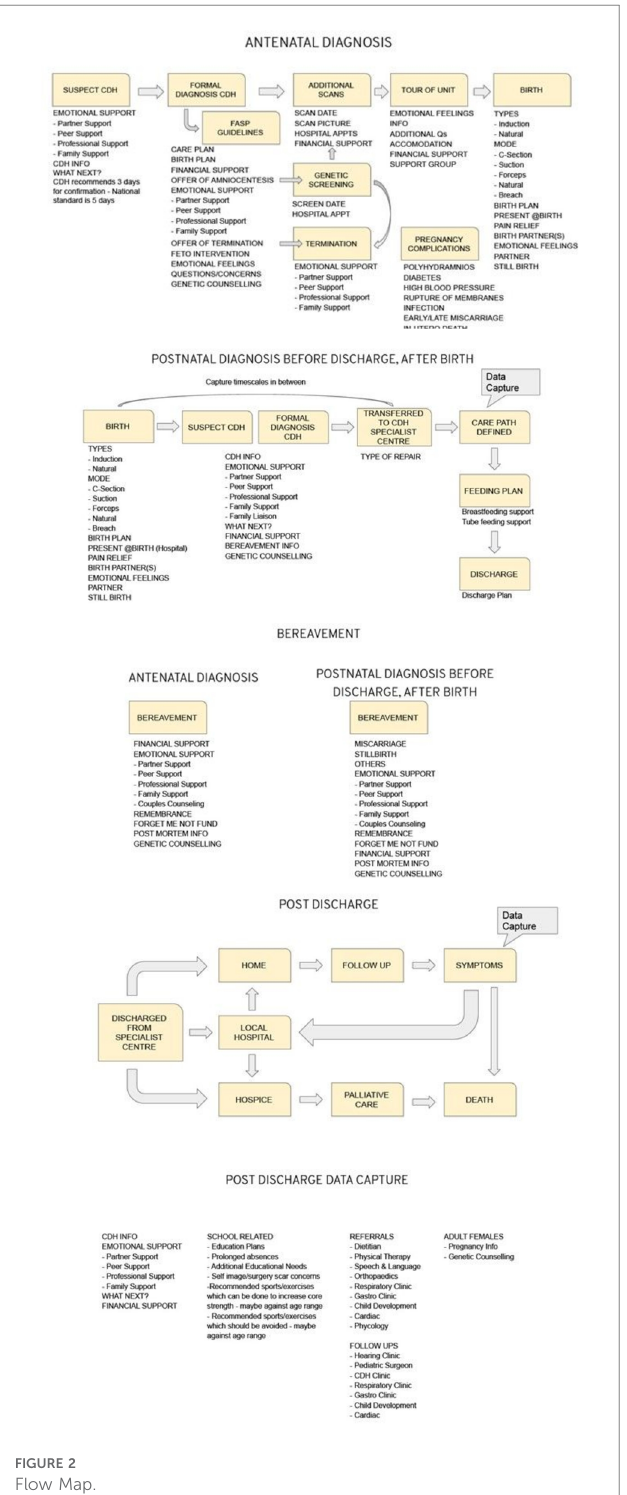
FIGURE 2 Flow Map.